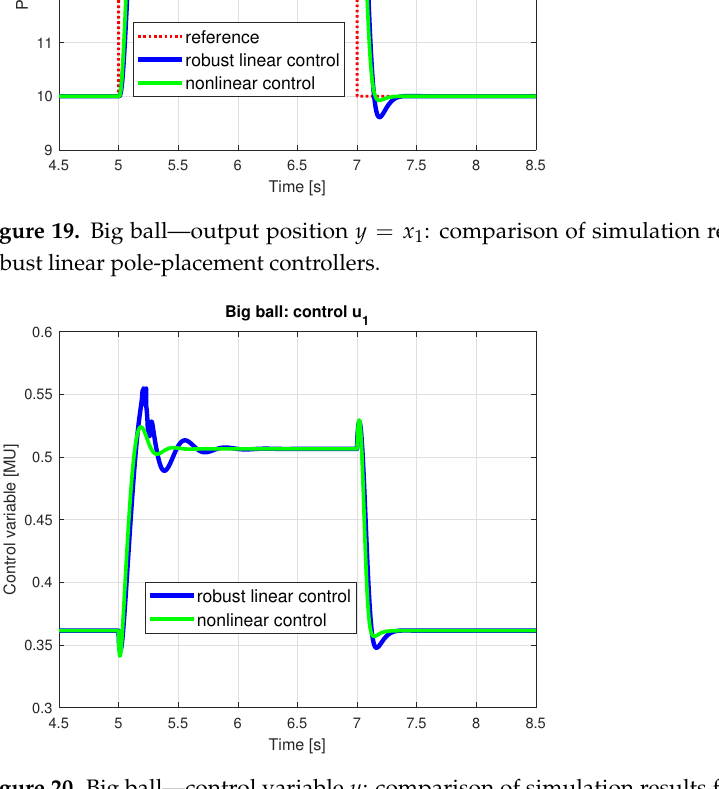
Figure 20. Big ball—control variable u : comparison of simulation results for nonlinear and robust linear pole-placement